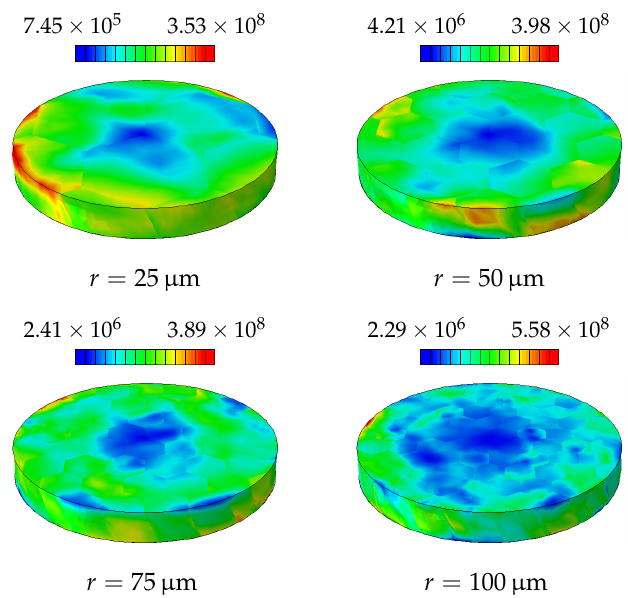
Figure 8. Final distribution of SSDs [ mm − 2 ] in the disc as a result of the applied torsion.